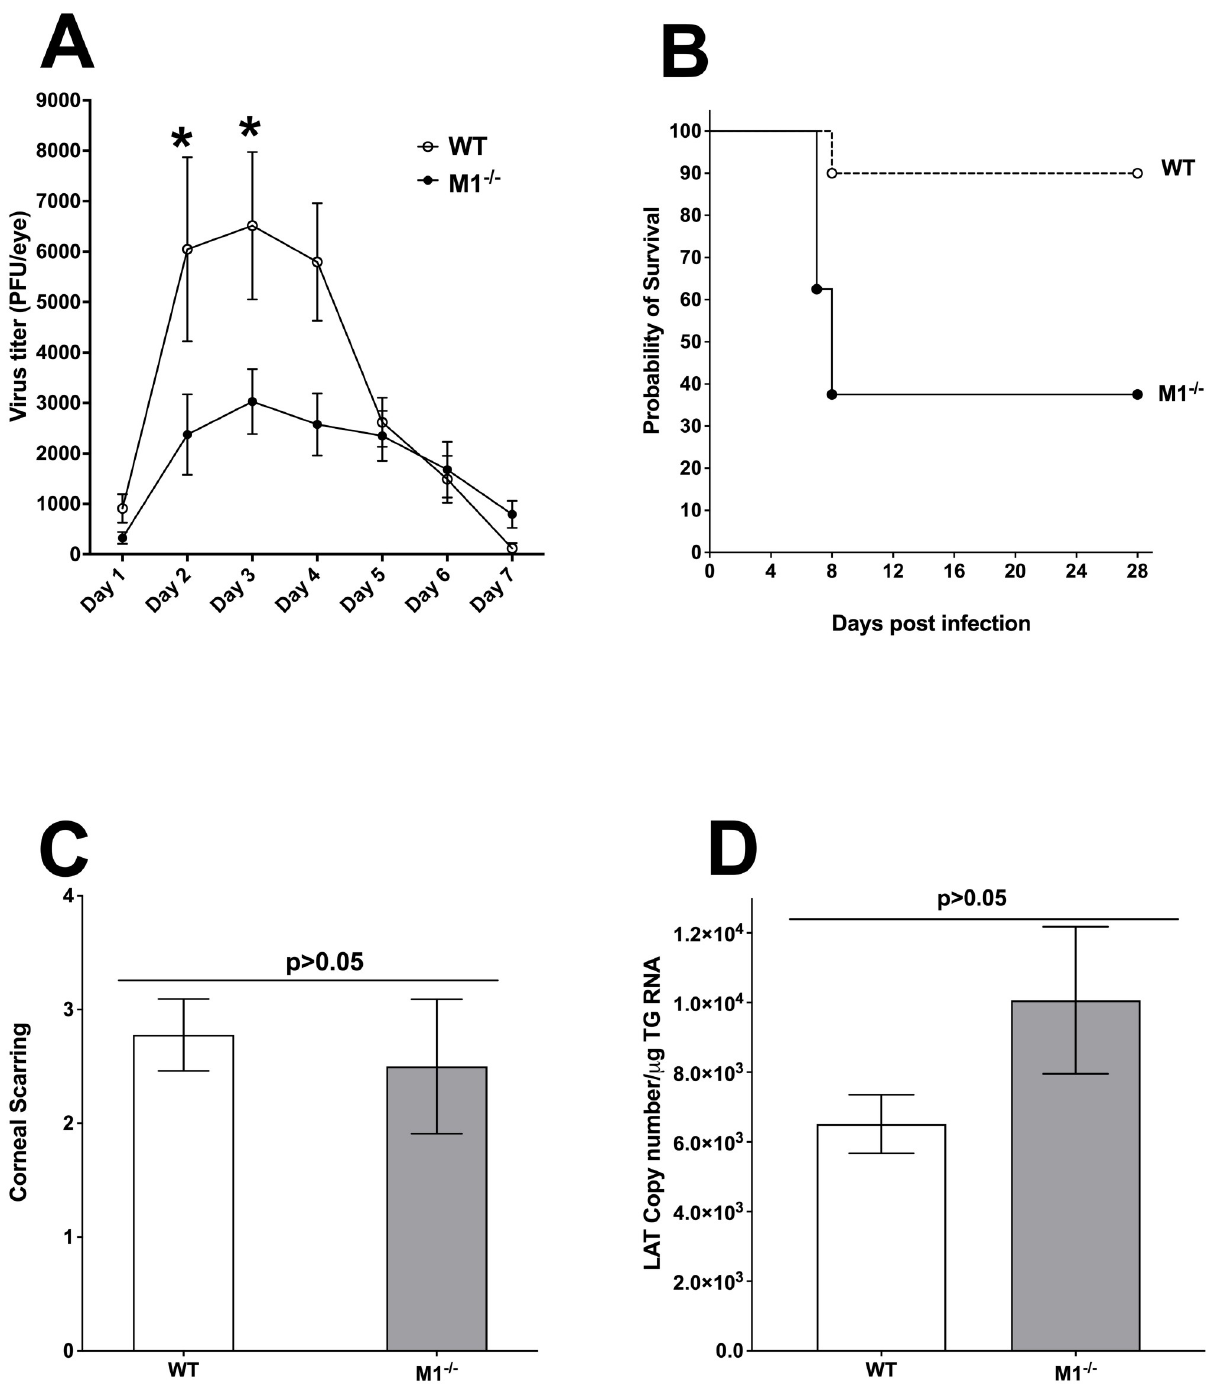
Fig 6. Virus replication, survival, corneal scarring (CS) and LAT expression after adoptive transfer of M1 macrophages to M1 -/- recipient mice. A) Virus replication in tears of infected mice. WT and M1 -/- mice, after receiving M1 macrophages from WT mice, were ocularly infected with 2 X 10 5 pfu/ eye of virulent HSV-1 strain McKrae. Tear films were collected from ocularly infected mice on days 1–7 PI and virus titers were determined by standard plaque assays as described in Materials and methods. Each point represents the mean + SEM of 20 eyes per group: B) Survival of M1 -/- recipient mice. Survival in the above infected mice was monitored for 28 days and the graph represents the average results from two different experiments using 9 WT mice and 3 M1 -/- recipient mice; C) CS in M1 -/- recipient mice. Corneal scarring (CS) in surviving mice were examined on day 28 PI as described in Materials and methods. CS scores represent the average ± SEM from 6 eyes for M1 -/- mice and 18 eyes for WT mice; and D) Latency levels in the TG of latently infected M1 -/- recipient mice were analyzed. On day 28 PI, individual TG from each mouse were harvested and quantitative RT-PCR was